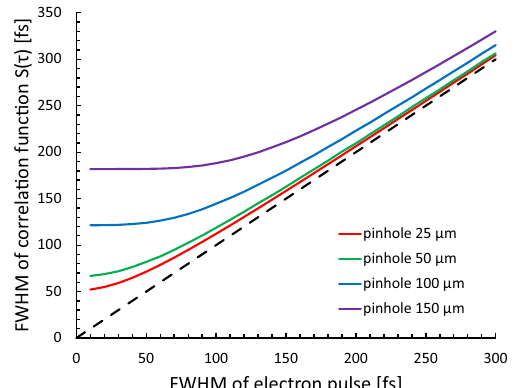
Figure 8. Pulse width of the correlation function with respect to the electron pulse width for a laser pulse width of 40 fs. The lines are calculated from Eq. (6) for pinhole diameters of 25, 50, 100, and 150